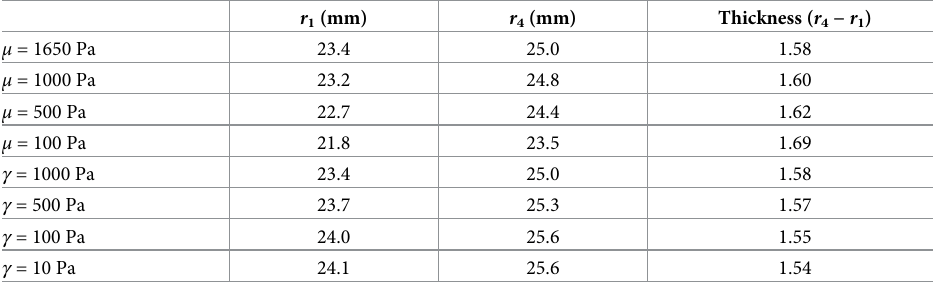
Table 6. Computational results showing how tissue softening influences thinning and dilation. g r = 0.1, g θ = 2, and g z = 1. Tissue softening is represented by decreasing the shear modulus μ or the fiber stiffness γ . When μ decreases ( γ = 1000 Pa, the original fiber stiffness), thickness increases slightly and r 1 decreases slightly, i.e., both thinning and dilation are weakened slightly. When γ decreases ( μ = 1650 Pa, the original shear modulus), thickness decreases slightly and r 1 increases slightly, i.e., both thinning and dilation are strengthened